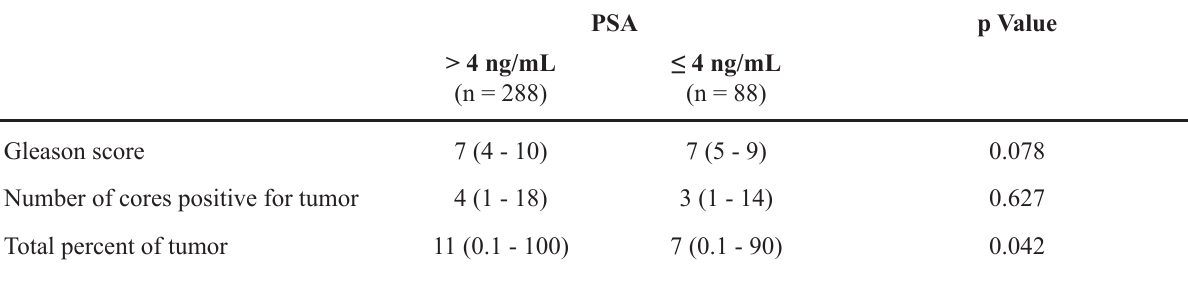
Table 3 – Tumor characteristics in prostate biopsies of 376 patients with PSA ≤ 4 ng/mL and PSA> 4